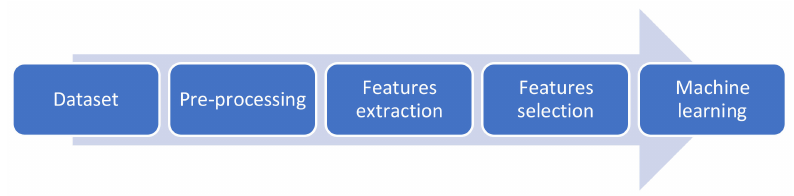
Figure 1. Flow chart of the proposed methodology.